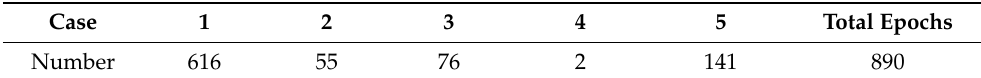
Table 1. The number of epochs corresponding to five